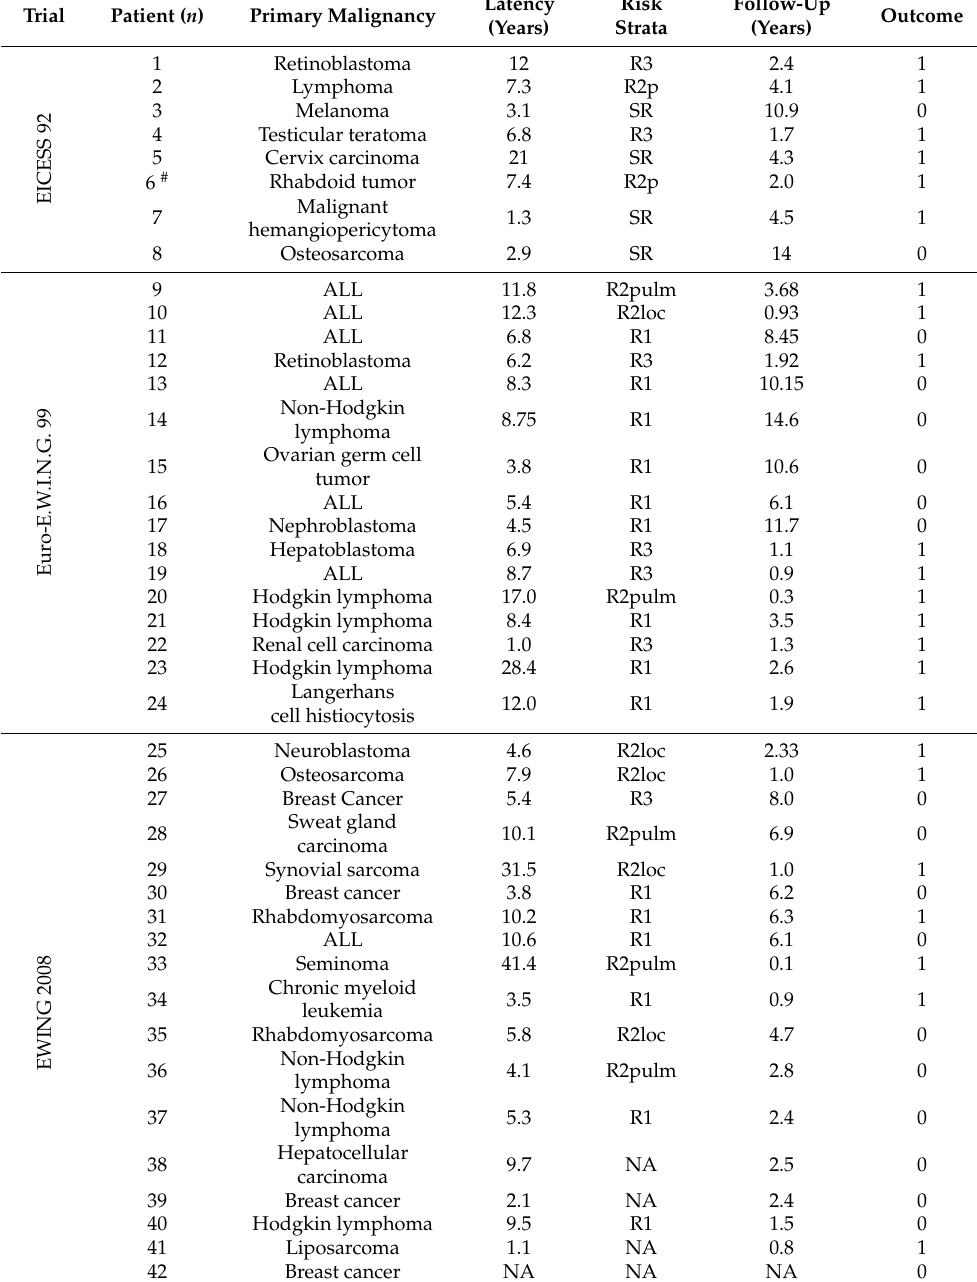
Table 3. Patient characteristics and clinical features of each patient with Ewing sarcoma as secondary malignant neoplasms in the EICESS 92, Euro-E.W.I.N.G. 99, and EWING 2008 trials. SR—standard-risk. Please see “Materials and Methods” section for more detailed information on risk strata, including randomization of R1/R2/R3. ALL—acute lymphoblastic leukemia. Outcome: 1 dead, 0 alive. Trial Patient ( n